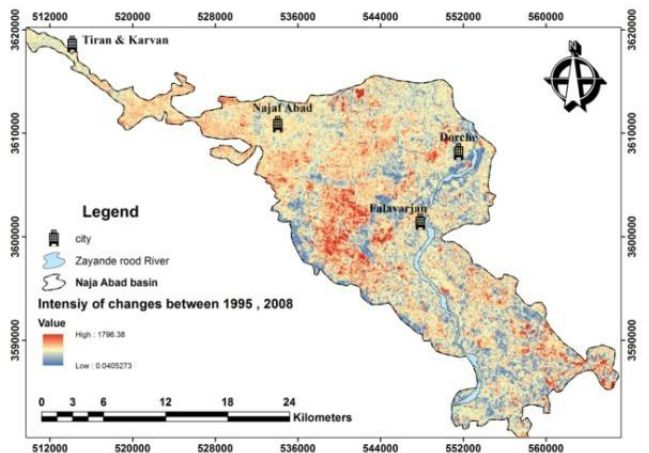
Figure 3. Change Vector image 1995-2008 (background scene: Brightness image 1995)